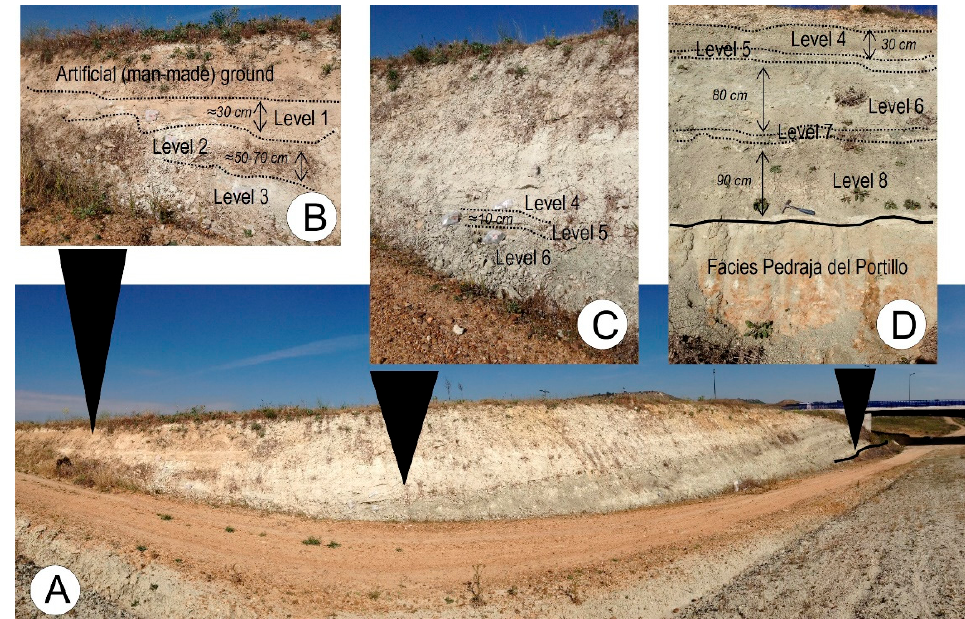
Figure 2. The DC Formation in the outcrop studied: ( A ) general view of the outcrop; ( B ) calcarenitic levels are predominant at the top; ( C ) intermediate levels; ( D ) bottom of the facies. The XRD analysis indicates the presence of phyllosilicates, quartz, calcite, dolomite, and alkali feldspar. On the oriented aggregates, smectite, illite, and palygorskite were identified in the clay fraction (Table 1). Table 1. Mineralogy of the clay levels identified within the DC Formation. The mineralogical semi- quantification was also performed using the oriented aggregates (OA) and after applying the method of reflective powers.